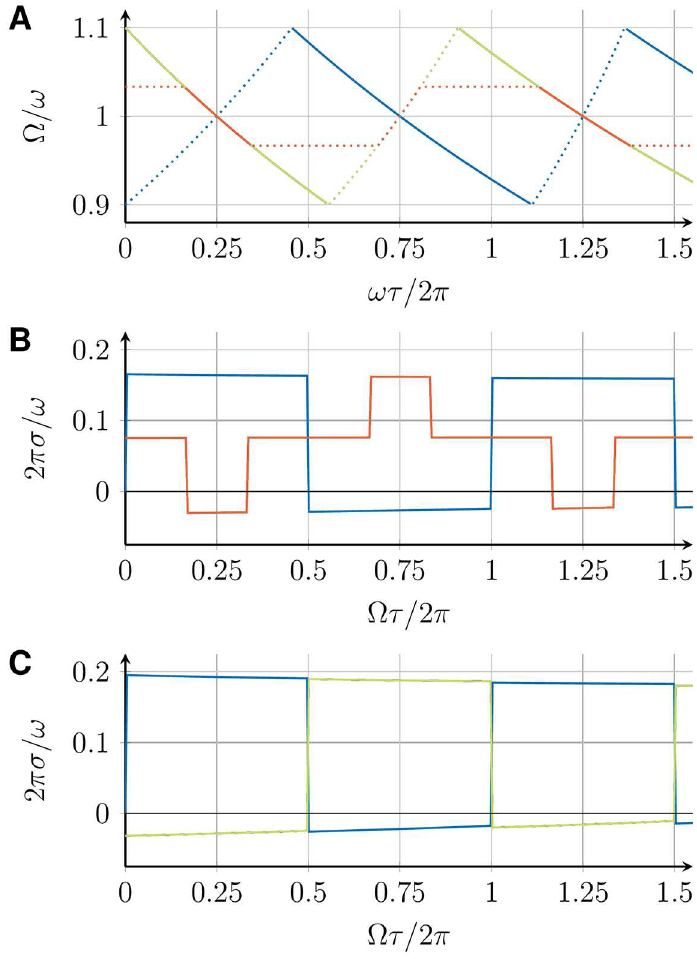
Fig 6. Global frequencies Ω and perturbation response rates σ for three coupled DPLLs. (A) Collective frequency Ω as a function of the transmission delay τ for the in-phase(blue), m -twist with m = 1, 2 (red), and checkerboard (green)synchronizedstates, as determinedfrom Eqs (10) and (20). Solid lines indicatestable solutions,dotted lines indicateunstable solutions.(B) Perturbation response rate σ , Eq (17), as a function of Ω τ for different synchronizedstates in a ring of 3 coupledDPLLs (color code as in panel A). (C) Perturbation responserate σ as a function of Ω τ for different synchronizedstates in a chain of 3 coupledDPLLs (color code as in panel A). All results are shown for a system of identicalPLLs with o ¼ 2 p rad s (cid:0) 1 , K = 0.1 ω , ^ p given by Eq (29) with a = 1 and ω c = 0.01 ω